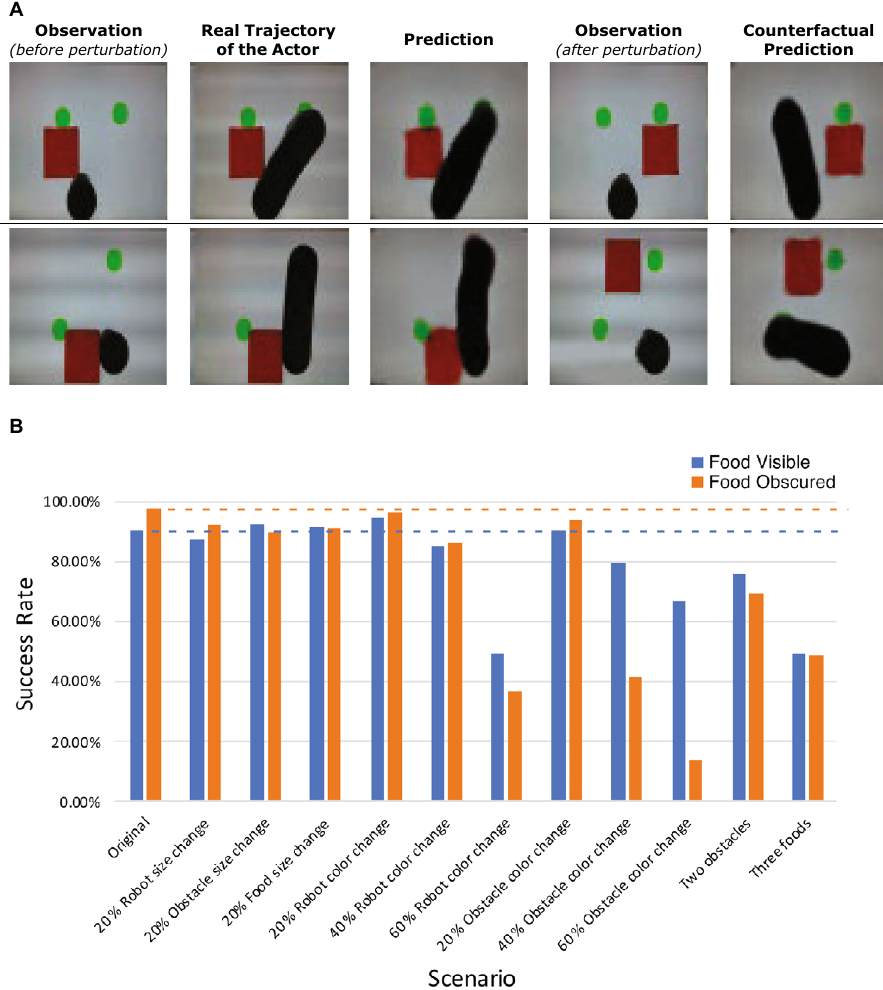
Figure 8. Counterfactual perturbation and prediction sensitivity. ( A ) The first column shows the original observation of the observer and the third column shows the prediction from the observer. The second column is the real trajectory of the actor robot after releasing it. We then move the obstacle to a different location from the first column. The resulted new observation of the observer is shown in the fourth column. The last column shows the counterfactual prediction after seeing this new observation. Both examples show the observer changes its prediction after the physically closest green dot becomes visible from being obscured by the obstacle. ( B ) Our model is able to give accurate prediction when the sizes of different objects as well as actor robot is changed. However, the observer model performs worse when the color is changed by 40%, and eventually breaks when the color is changed by 60%. The size change in these experiments is limited by the arena size (128 × 128